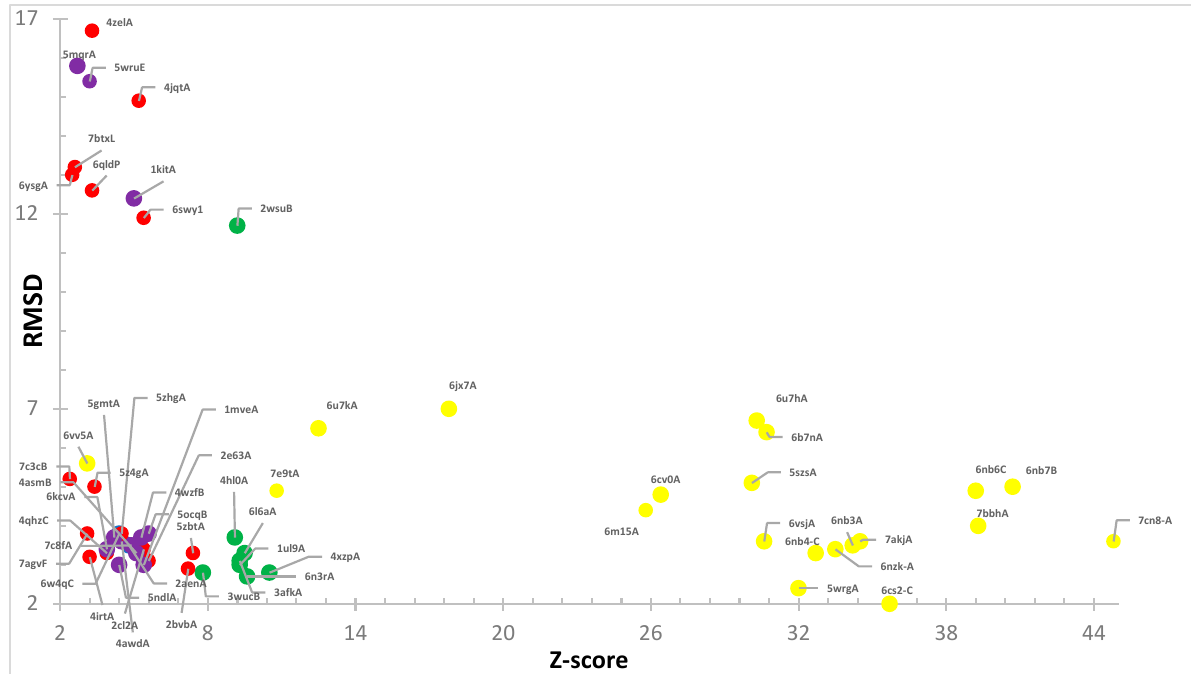
Figure 6. Relationship of two measures (Z-score and RMSD) for protein structures’ similarity. The structures that belong to three clusters are colored (yellow for S protein structures, green for Lectin (Galectin) and purple for Lyase (Hydrolase)). Structures that do not belong to three clusters are red-colored. Lyase (Hydrolase) and Lectin (Galectin) are very close to each other on the basis of the correlation between RMSD and Z-score.